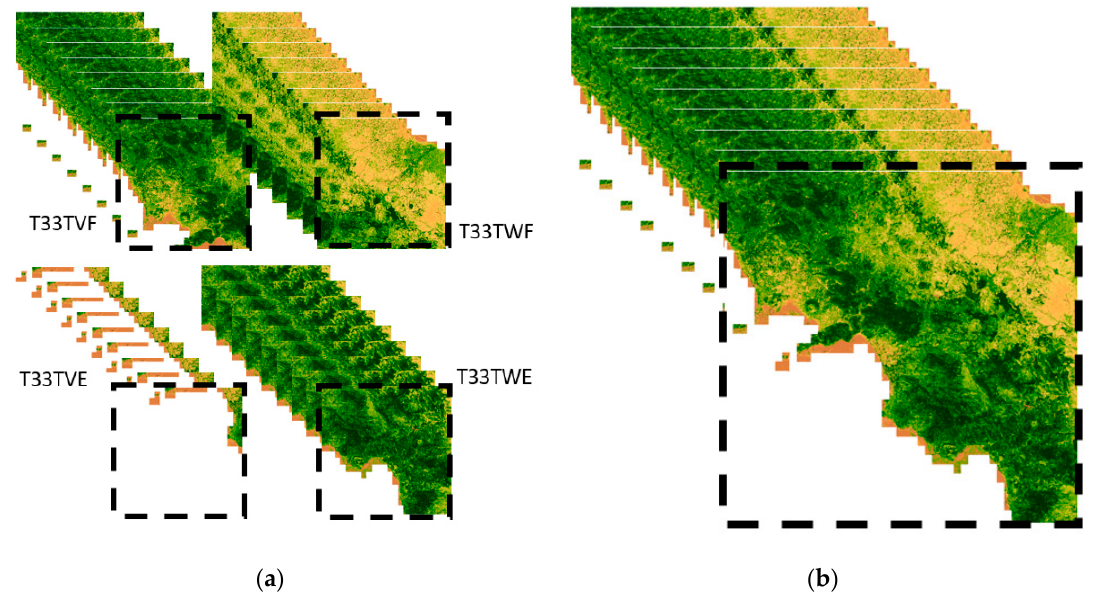
Figure 4. (a) The different tiles and images involved in the spatial aggregation process. (b) The final product after the spatial aggregation algorithm composed by a total of 75 images/observations spanning the year 2018.